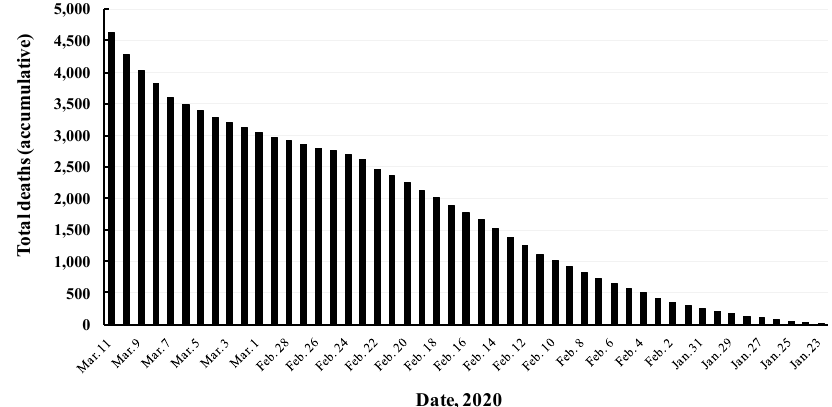
05001,0001,5002,0002,5003,0003,5004,0004,5005,000 Fig. 4: Accumulative number of deaths by COVID-19. Data is obtained from Situation Report 51 (WHO, 2020b) Fig. 5: Change in the number of daily deaths by COVID-19. Data is obtained from Situation Report 51 (WHO, 2020b) Fig. 6: COVID-19 mortality rate by sex (Worldometer, 2020)